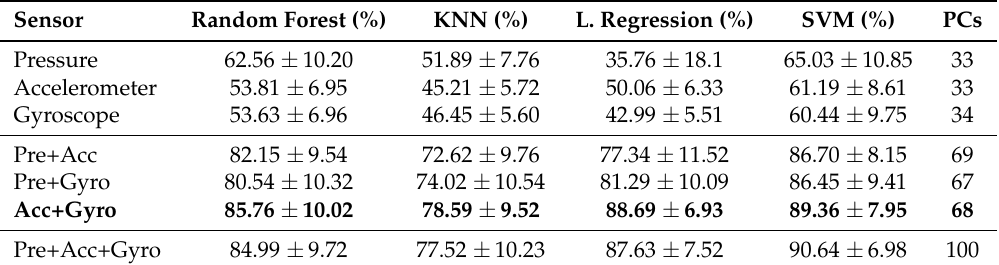
Table 3. Accuracy of the gait pattern classification using the variance combinations of the smart shoes sensor features based on the optimal number of PCs. Pre, Acc and Gyro denote pressure sensor, accelerometer and gyroscope, respectively.